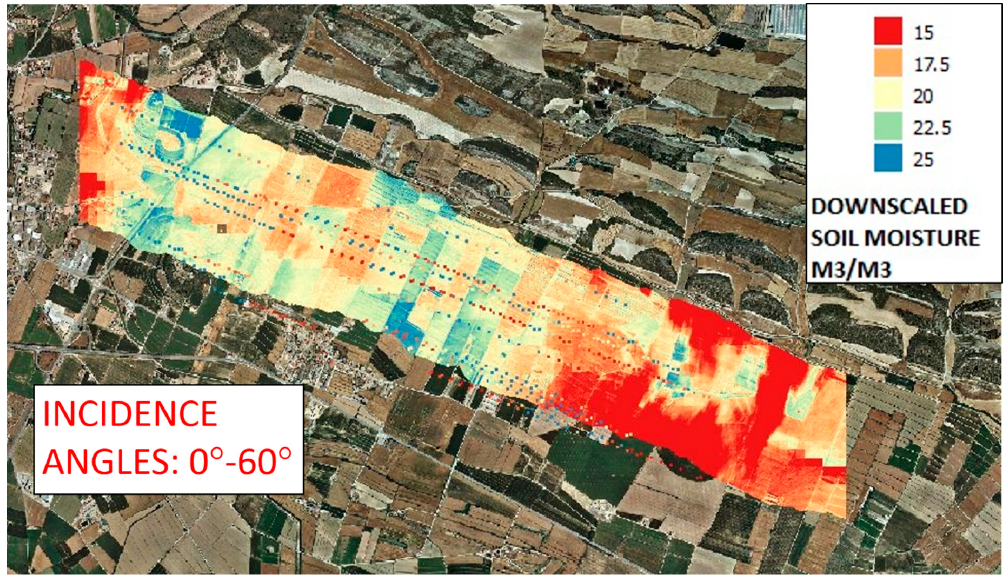
Figure 19. ARIEL downscaled and CORTO GNSS-R retrieved SM: all incidence angles included.